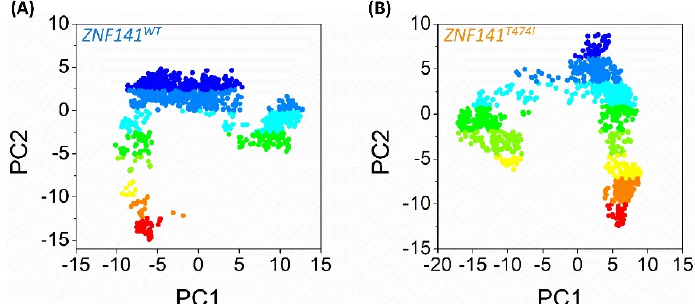
Figure 7. Both systems’ principal component analysis (PCA). The scattered plots ( A , B ) for the ZNF141WT and ZNF141T474I exhibit motion projection by showing the first two eigenvectors (PC1 vs. PC2) acquired from each system’s full 100 ns trajectory. The color gradient depicts the shift of eigenvectors from dark red to blue during MD simulations.